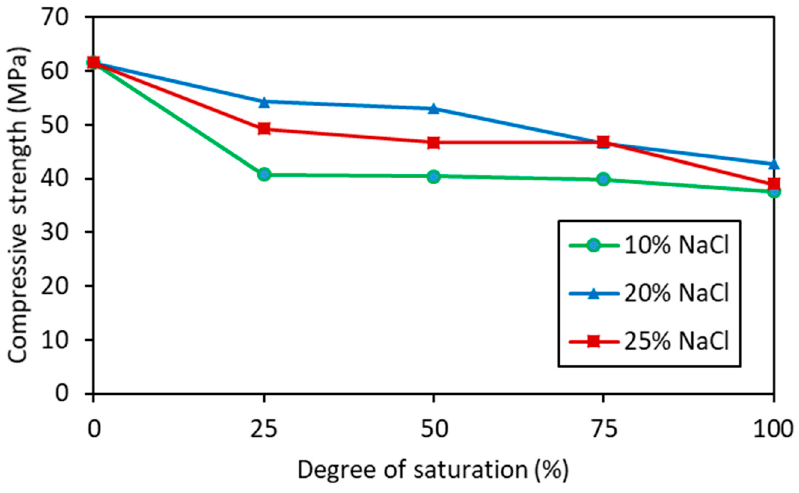
Figure 4. Variation of compressive strength of siltstone in 10%, 20%, and 25% NaCl.